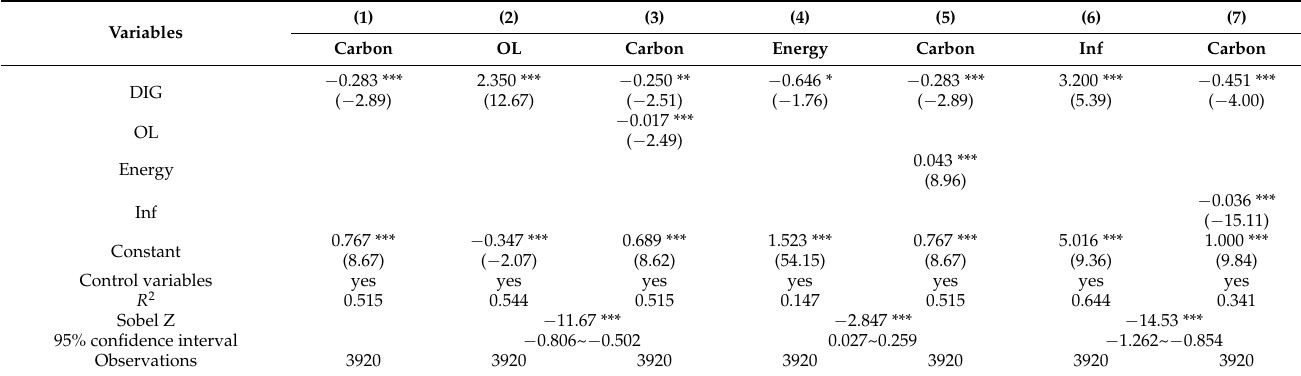
Table 5. Mechanism test.